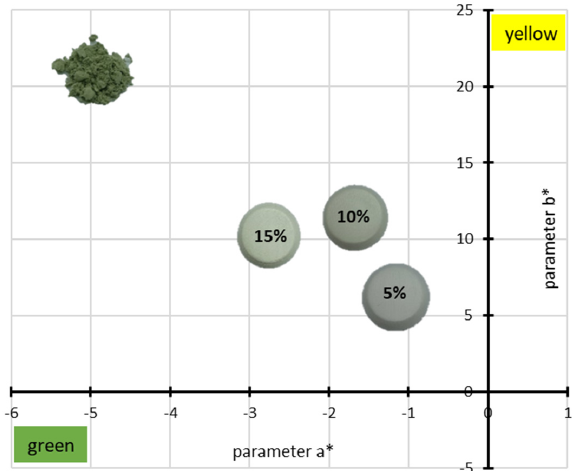
Figure 7. CIELAB color space graph for VO(IV)- bis (abietate) in powder form and dispersed in commercial white paint.